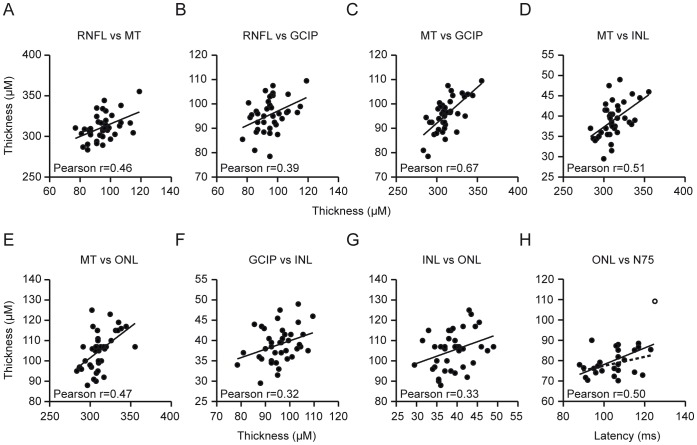
Correlations between layers. A–HThe significant correlations between the thickness of the different retinal layers and the VEP parameters of the patients’ left eyes are displayed and the Pearson r is indicated (p<0.05, Pearson). H The continuous lines resemble the linear regression including, and the dotted lines excluding, an outlier with beginning hepatic failure (the outlier is marked as unfilled dot, Pearson r is indicated considering the outlier).